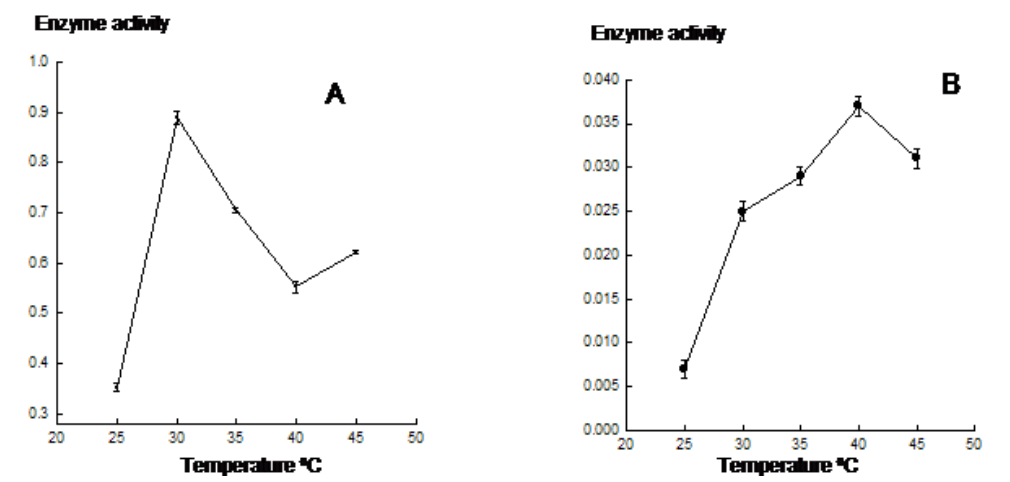
FIGURE 4. Spectrophotometric evaluation of the extract β -lactamase activity (induced) against ampicillin (A) and cephalexin (B) at pH